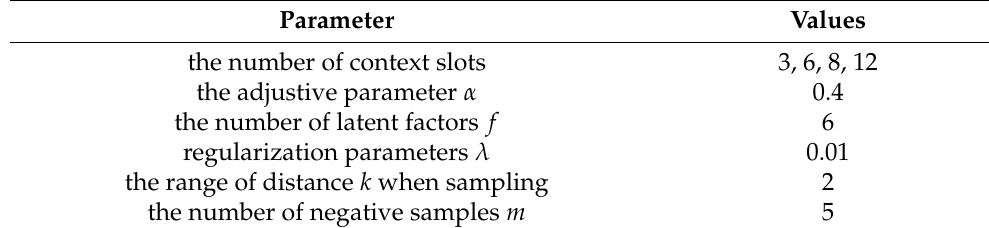
Table 3. Parameter settings.